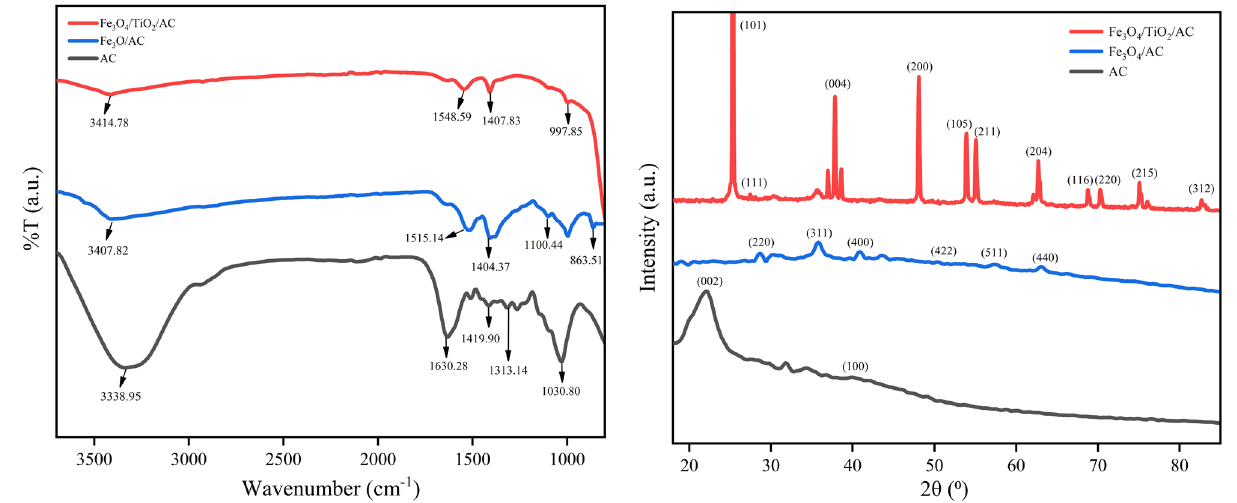
Figure 2: FTIR spectra of materials. Figure 3: XRD pattern of